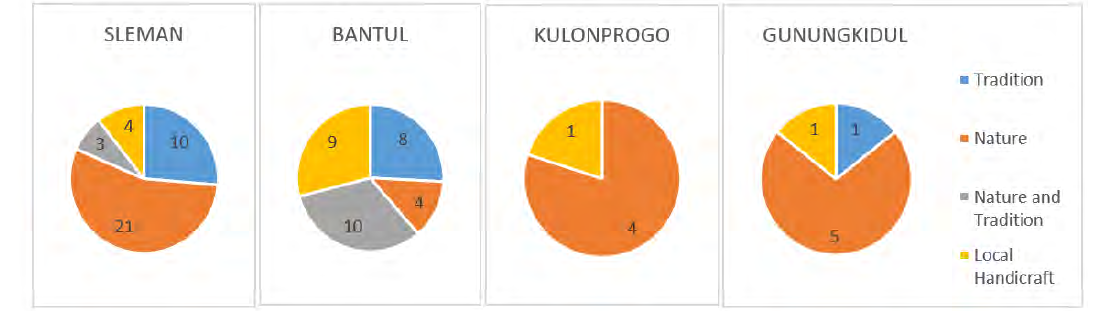
Figure 3. Graph of distribution number of tourist villages based on the potential tourist attraction in 4 districts of DIY province (author, 2017)